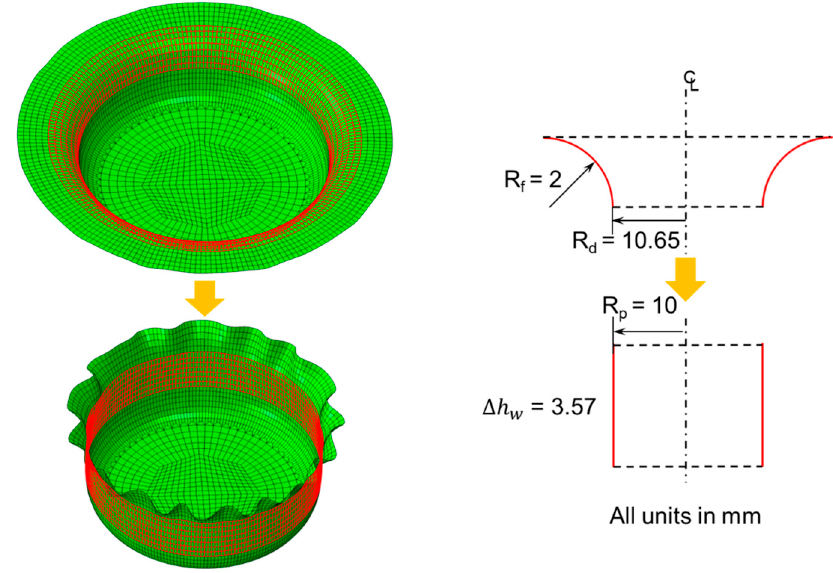
Figure A1. Snapshots of the onset of wrinkling ( top ) and onset of ironing ( bottom ) for the simulated cup under 91 N. Highlighted region deforms from a quarter toroidal surface to a right circular cylinder.